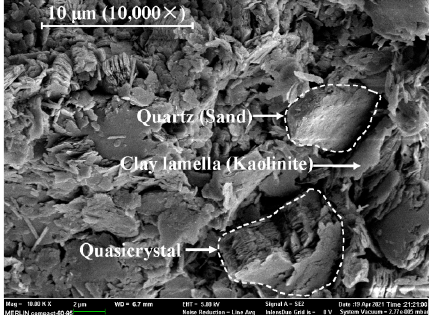
Figure 4. A SEM image of GRS finer than 0.5 mm and at a dry density of 1.44 Mg/m 3 .